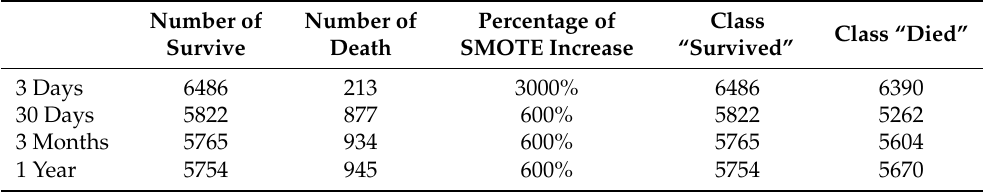
Table 2. Number of instances increased by SMOTE